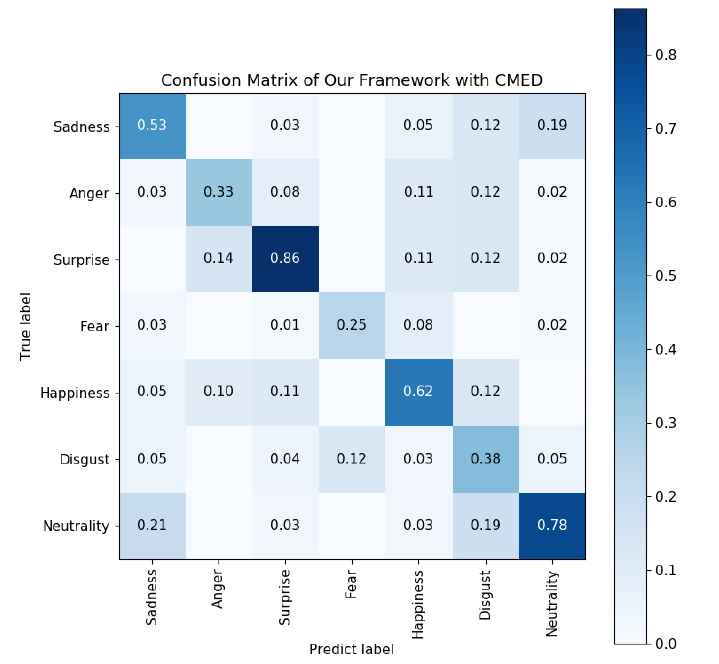
Figure 9. Confusion matrix of our framework with